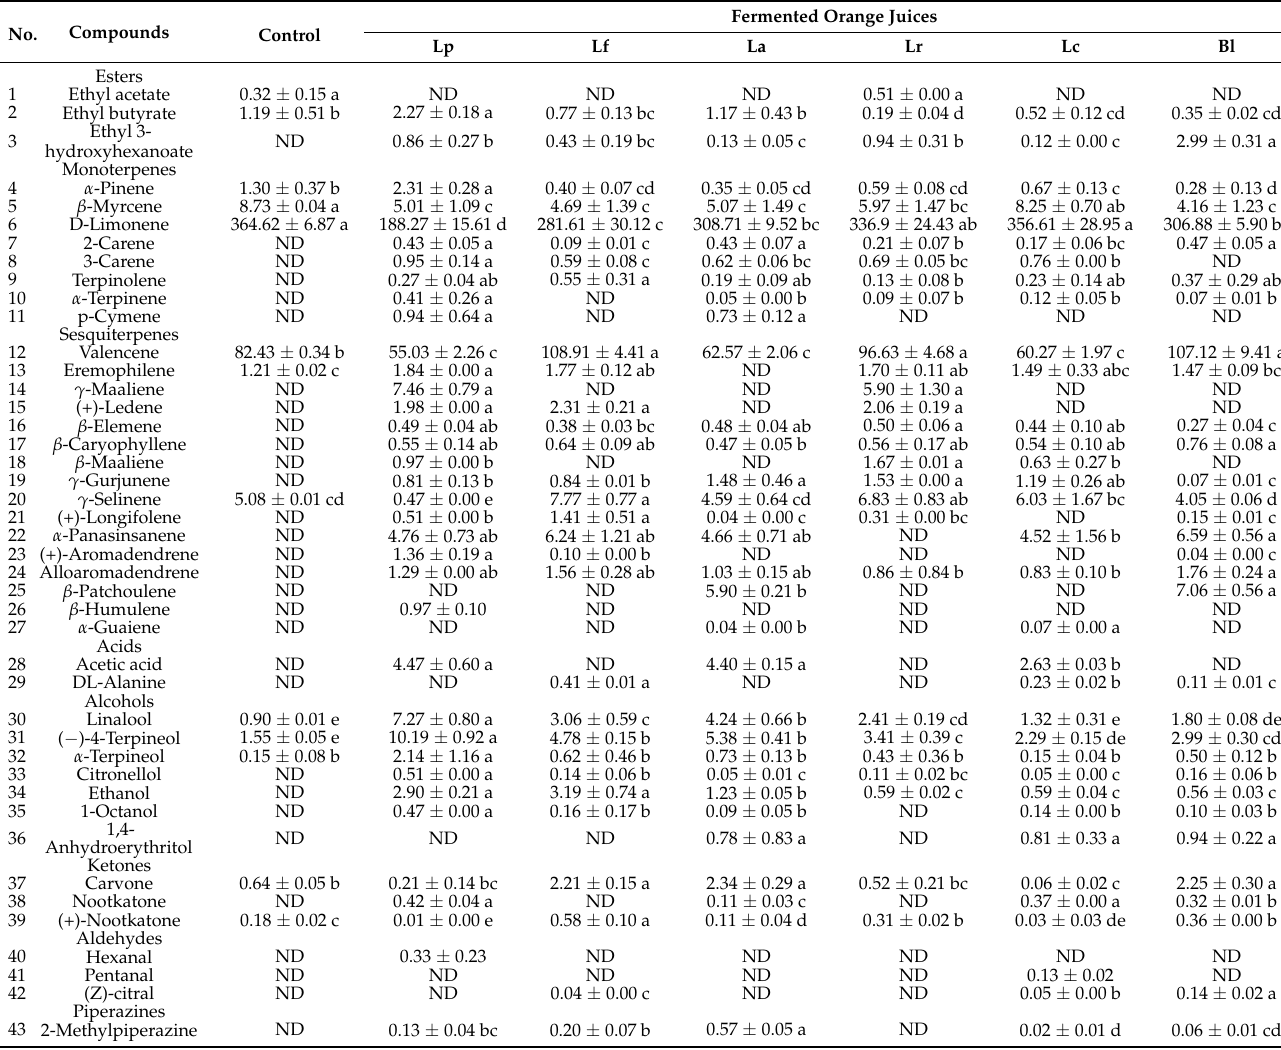
Table 2. Quantitative concentrations ( µ g/mL) of volatile compounds in fermented orange juices and control ( n =